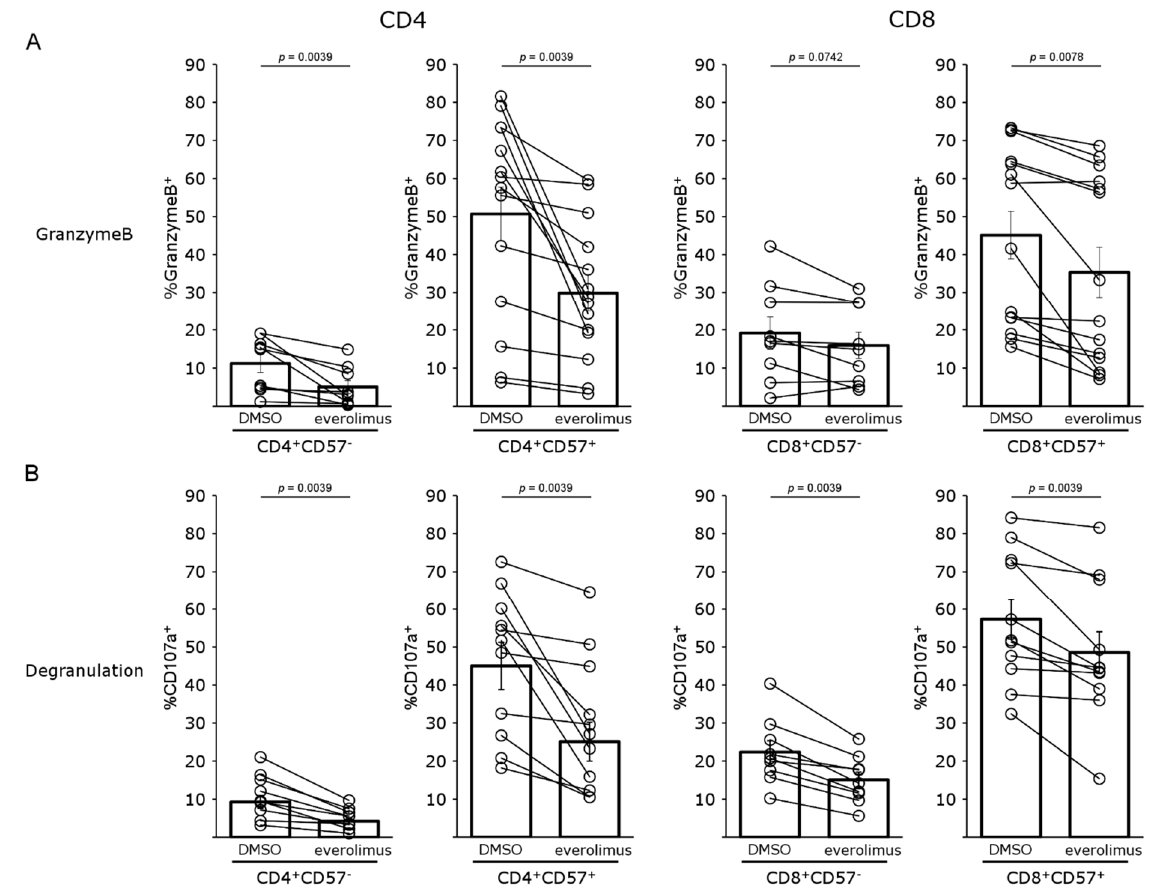
Figure 5. Granzyme B expression and cytotoxicity in CD4 + CD57 − , CD4 + CD57 + , CD8 + CD57 − and CD8 + CD57 + T cells treated with mTOR inhibitor: ( A ) Expression of granzyme B and ( B ) CD107a by CD4 + CD57 − , CD4 + CD57 + , CD8 + CD57 − and CD8 + CD57 + T cells after 5 days of culture with allogeneic aDCs without (DMSO) or with everolimus, followed by incubation with target cells for 4 h. Nine (CD57 − ) and 14 (CD57 + ) ( A ) or 9 (CD57 − ) and 11 (CD57+) ( B ) independent experiments (pictograms) were performed. The mean (bar chart) and SEM are shown.